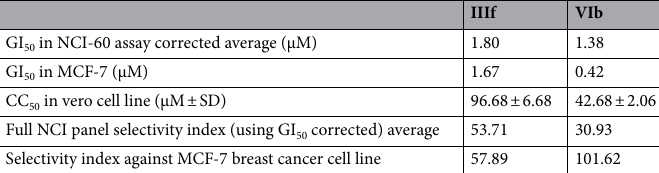
Table 3. Cytotoxicity of ( IIIf ) and ( VIb ) against normal and tumor